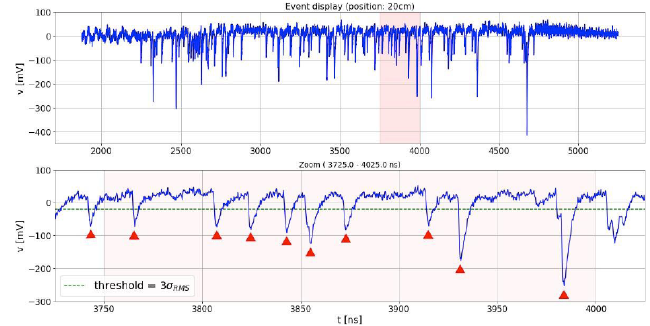
Fig. 7. Schematic of the tests performed at the St Luke hospital at the University of Dublin, Ireland, using an ion chamber or a fast Silicon detector. The signal from the ion chamber is integrated over a few seconds in time whereas the UFSD information can be instantaneous.